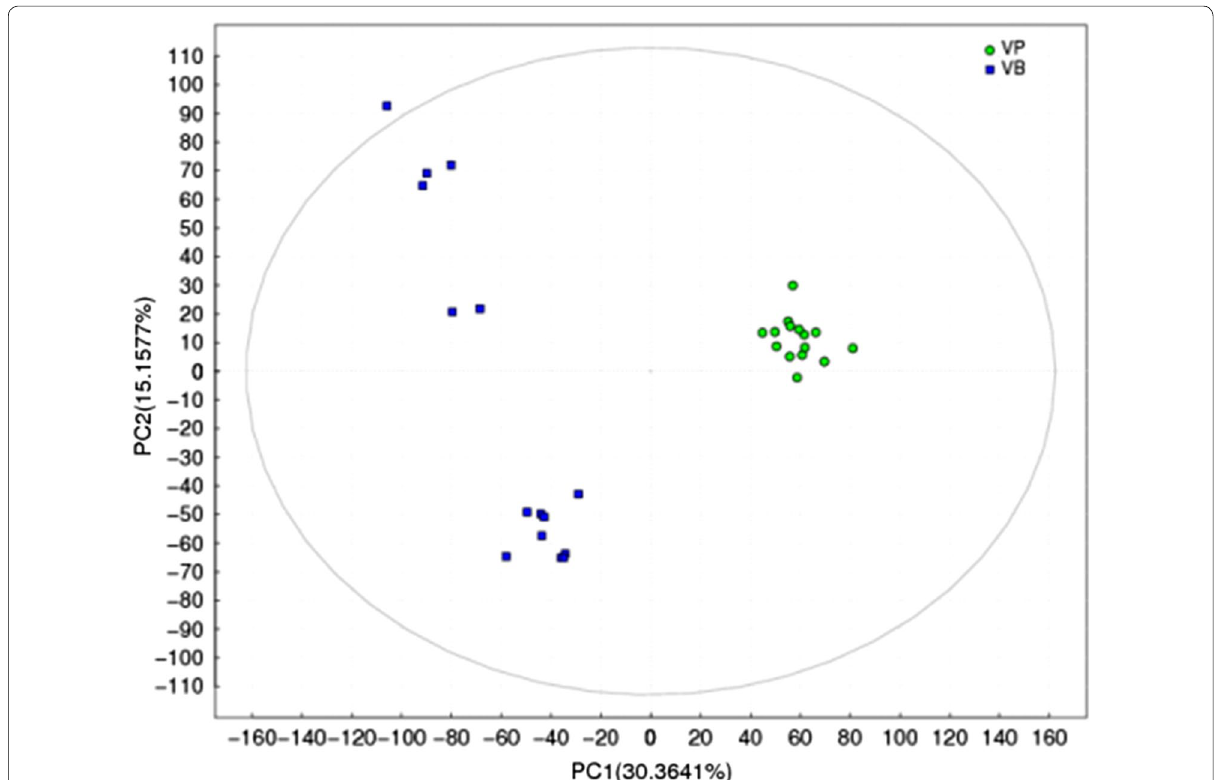
Fig. 4 PLS-DA score separating vanilla pods and vanilla beans away from each other ( VP vanilla pods, VB vanilla